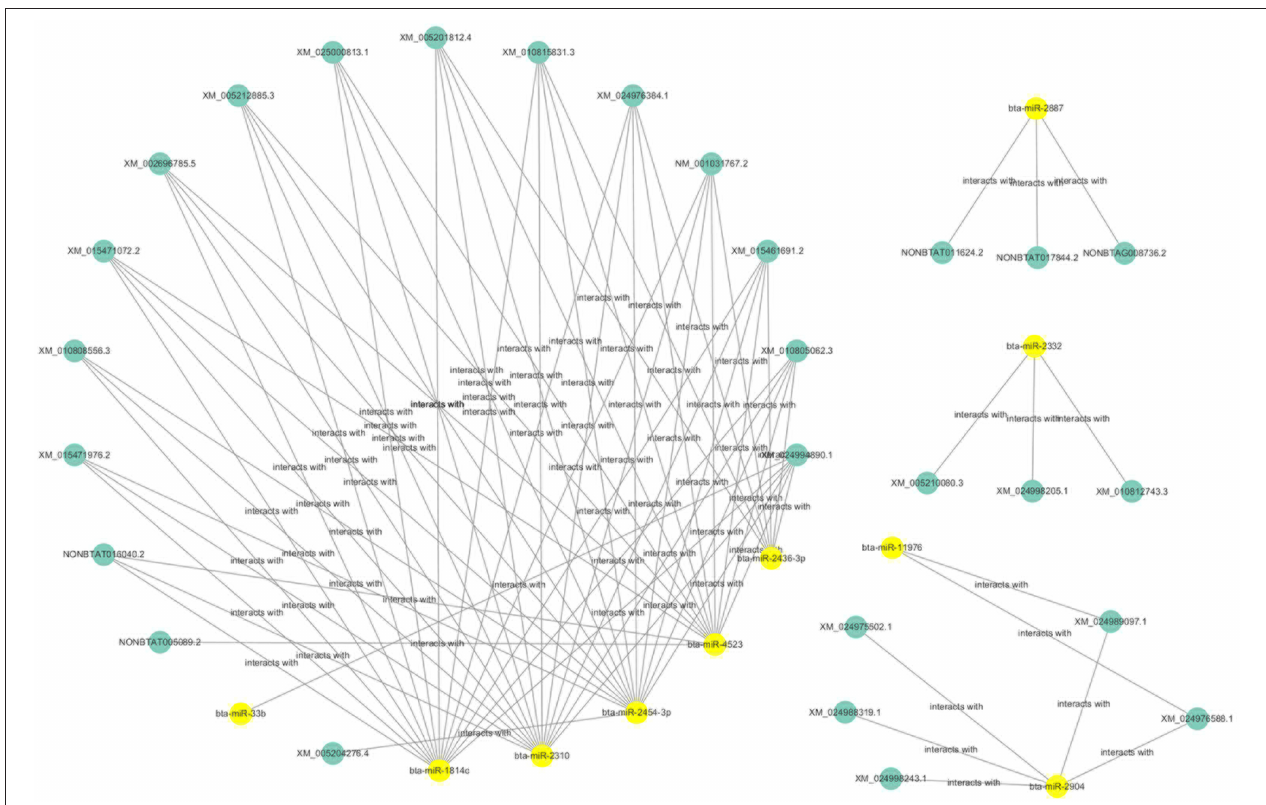
FIGURE 9 | Competitive endogenous relationships between DEmRNAs, DEmiRNAs, and DElncRNAs are shown.